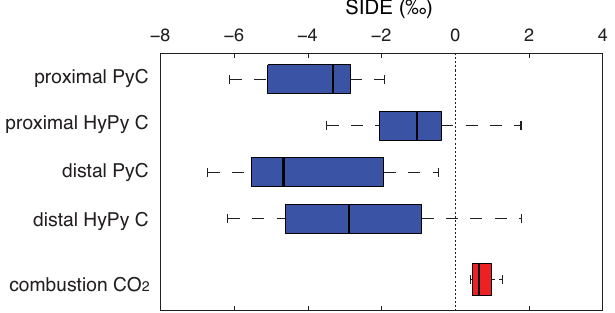
Figure 5. Box and whisker plot of isotopic disequilibrium val- ues (SIDE = δ 13 C flux – δ 13 C pool ) for proximal and distal fluxes of PyC and HyPyC, and combustion CO 2 calculated by mass bal- ance ( n = 16 for proximal components; n = 15 for distal compo- nents, n = 14 for combustion CO 2 ). Line at centre of box repre- sents the sample median, box represents 25th and 75th percentiles and whiskers represent